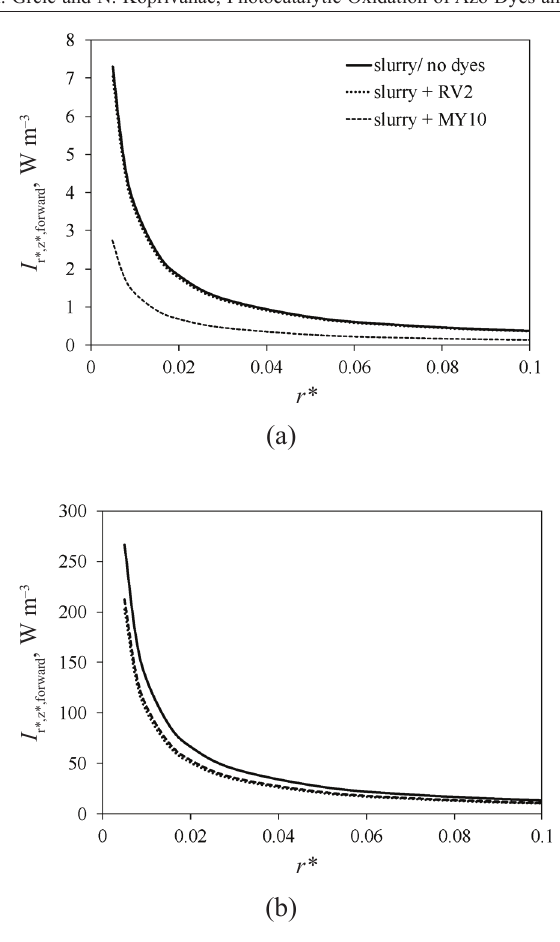
Fig. 4 – Radial profiles of the forward photon flux in cylin- drical photoreactors BRa (a) and BRb (b) with light emission maxima at 365 and 254 nm (z* = 0.5, 0.4 g TiO